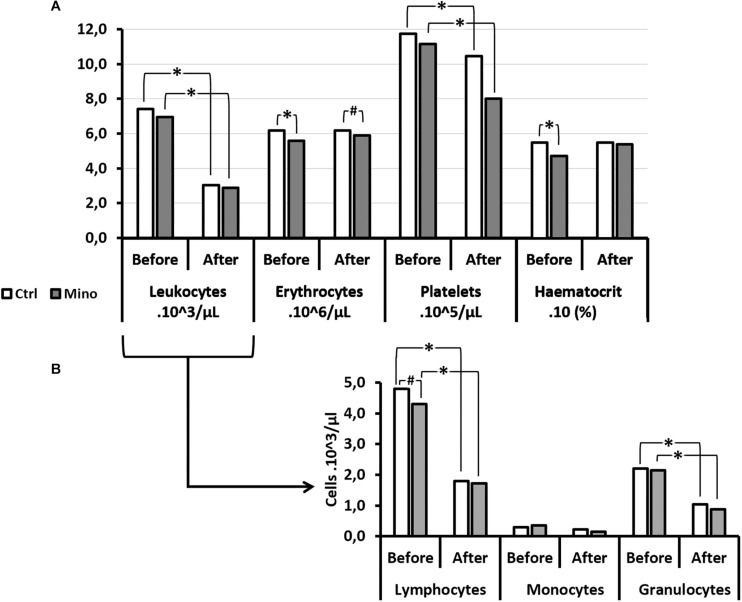
Effects of Minocycline on blood cells count before and after the hyperbaric exposure. (A) Histograms represent main blood parameters. (B) Histograms focused on white blood cells sub-populations. As results showed haemoconcentration linked to the hyperbaric exposure, the blood parameters registered after the dive were corrected individually depending on the variation in the haematocrit (notify by “c”). *Notes significant difference (p < 0.05) and # denotes p < 0.10 (trend) between groups. Ctrl, Control mice (no active molecules, white blocks); Mino, Minocycline (90 mg/kg, gray blocks).